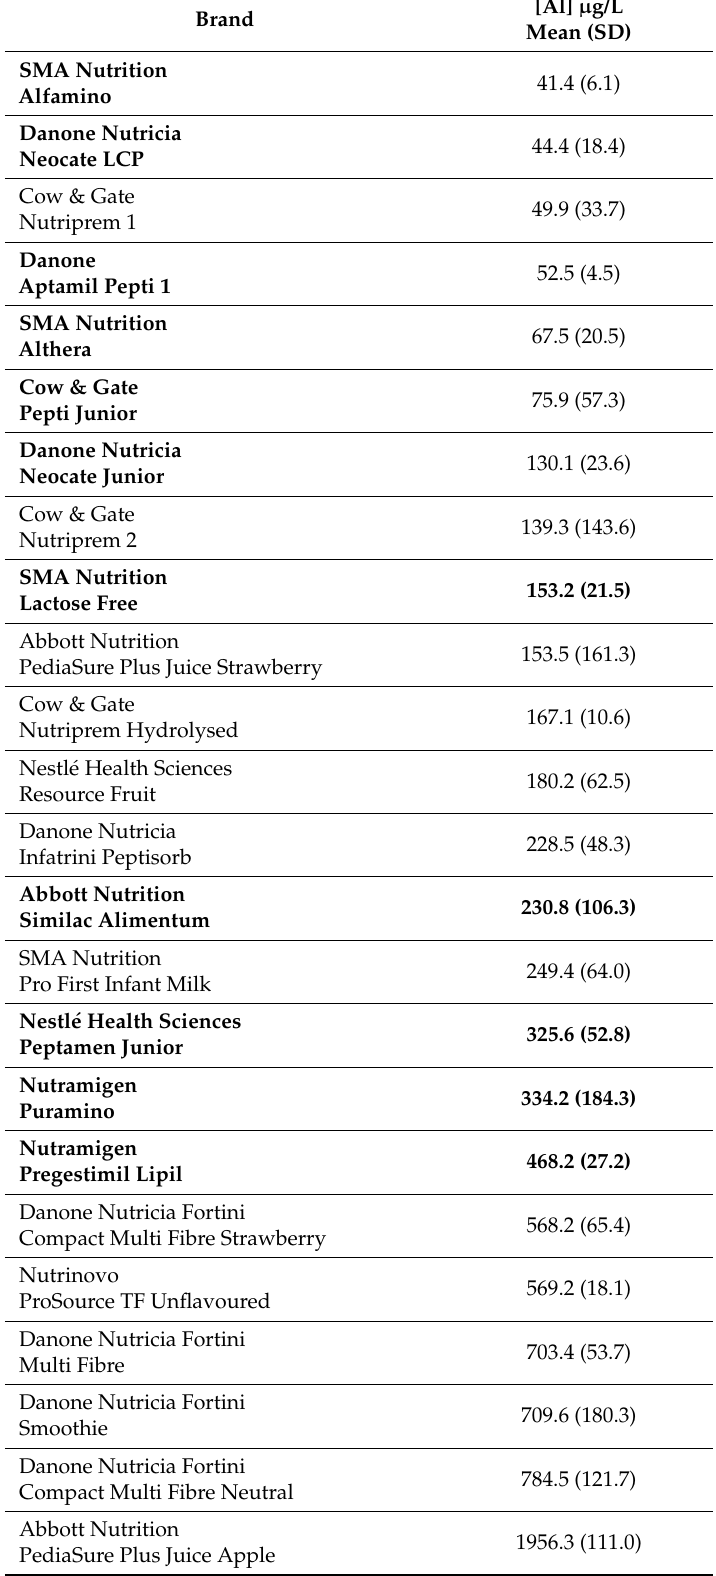
Table 5. The concentration of aluminium in prescription formulas prepared as per the manufacturer’s instructions. Powdered formulas are identified in the table as bold script. Mean and SD are given, n =